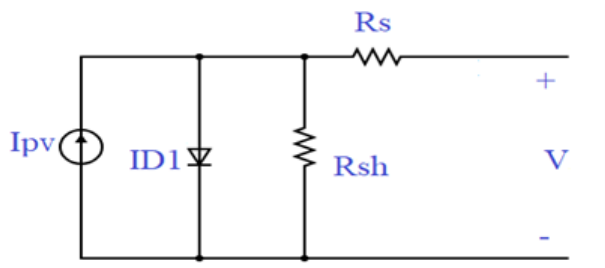
Figure 1. Equivalent circuit of the